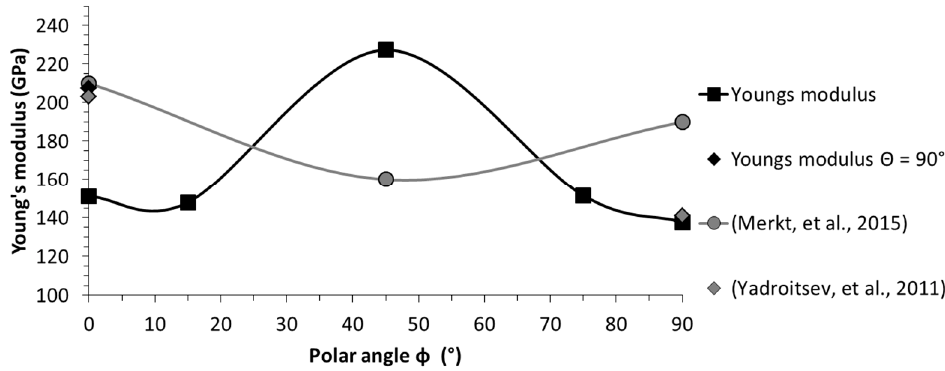
Figure 5. Orientation dependency of Young’s modulus; comparison with reported results [4,65].